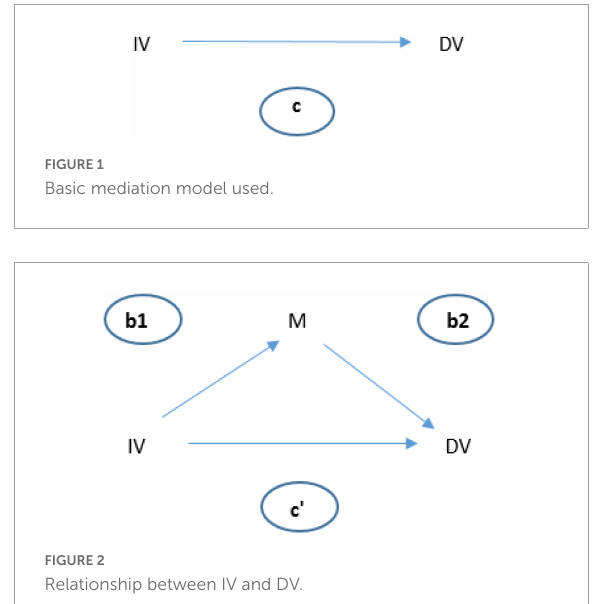
FIGURE2 Relationship between IV and